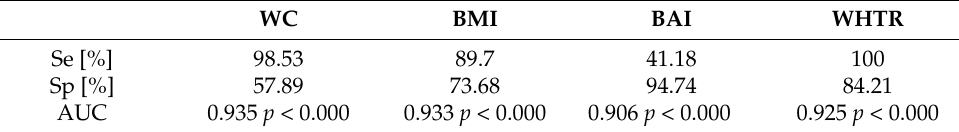
Table 4. Sensitivity and specificity of